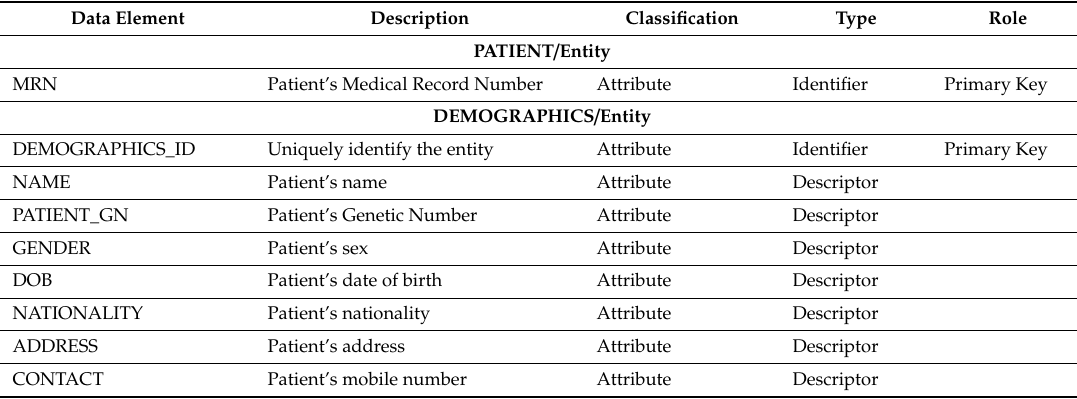
Table 3. Entities and attributes